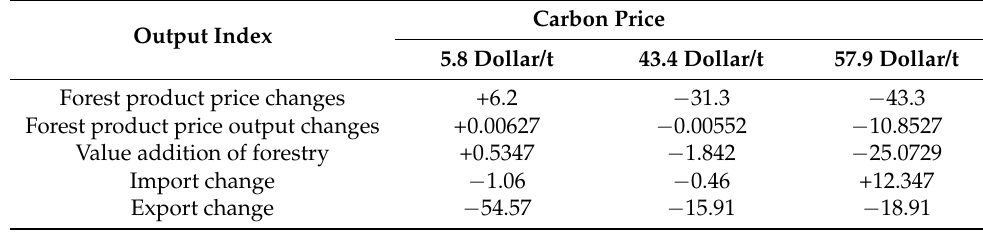
Table 3. The change of forestry output under different carbon prices